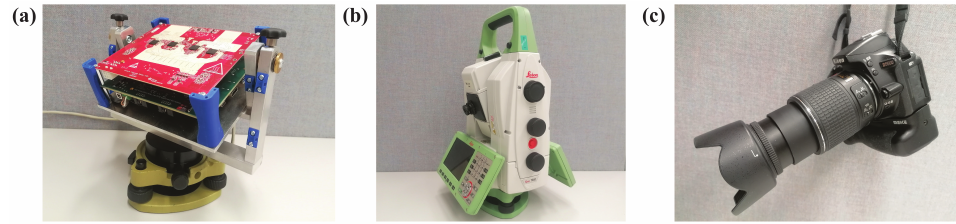
Figure 3. Instruments: ( a ) MIMO-SAR system, ( b ) total station, and ( c ) video camera.